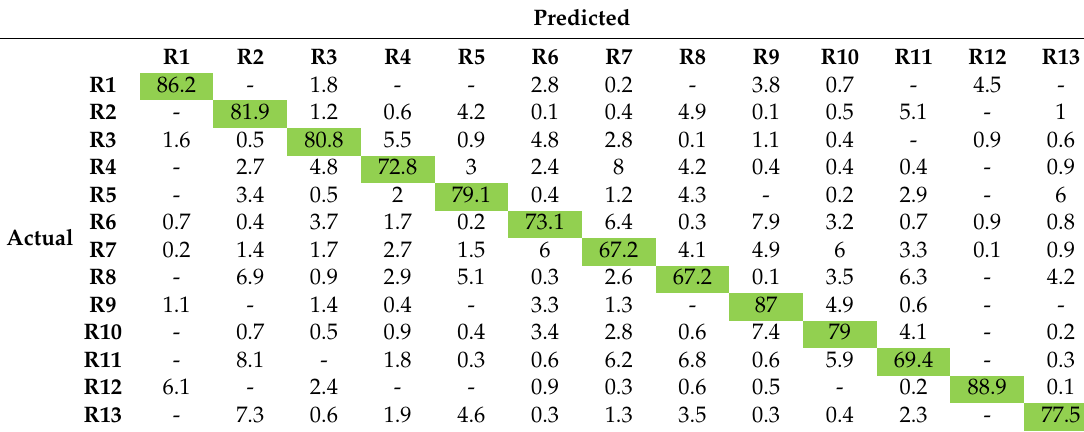
Table 12. Average confusion matrix of proposed method on CAVE-DB from two-fold cross validation.